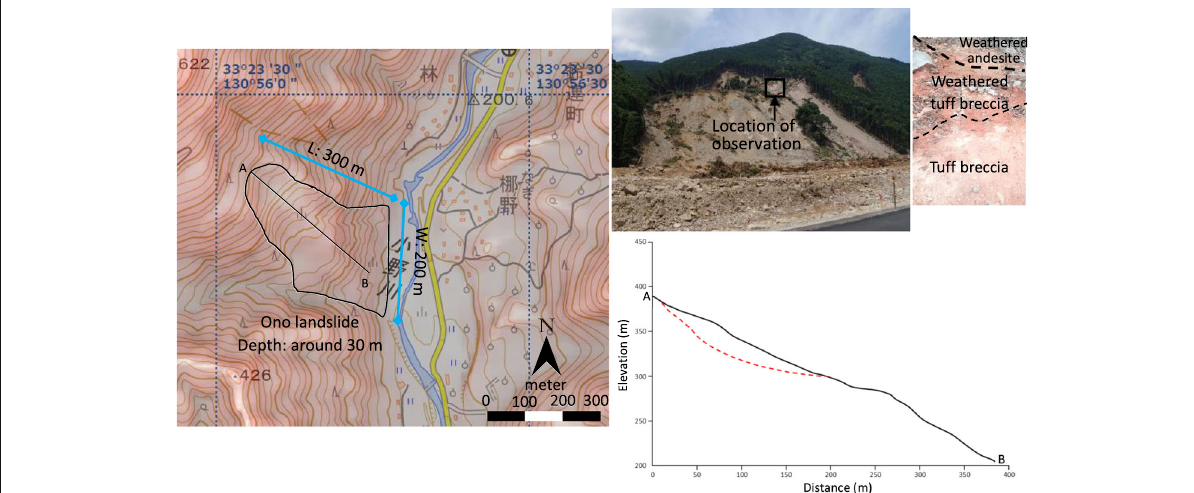
Fig. 6 Topographic map (Geospatial Information Authority of Japan 2020) with cross-section (modified Chigira et al. 2018) (photos taken on July